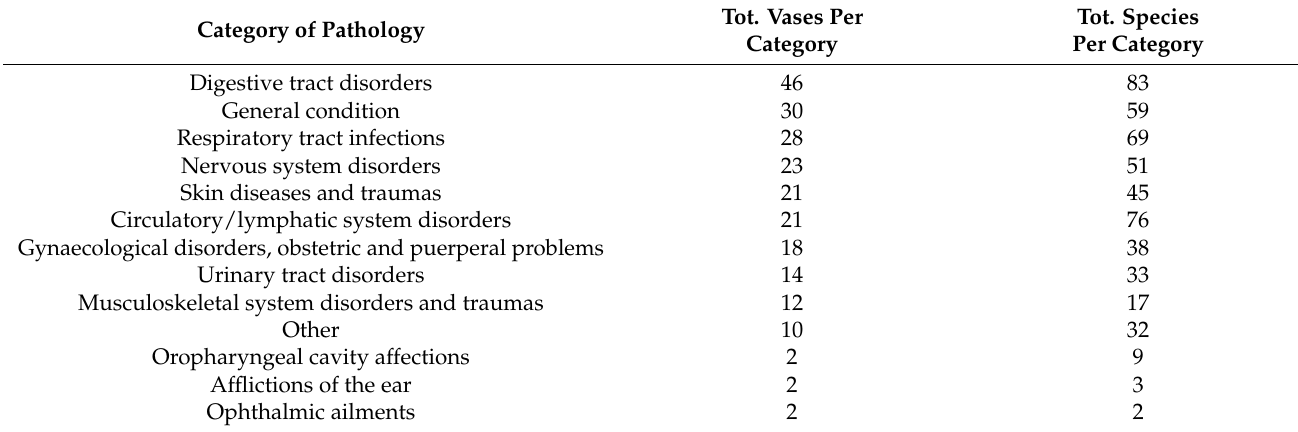
Table 2. Categories of the pathologies treated with the 108 plant-based remedies, according to historical sources published between the XV and the XIX century [8–78]. The total number of vase-remedies used for the treatment of each category, along with the total number of plant-based ingredients in the remedies, are